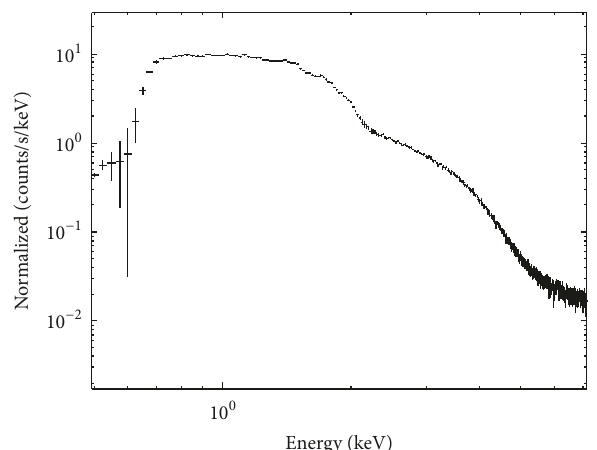
Figure 5: Spectrum of Crab in the 0.5 ∼ 7 keV band from TSXS.